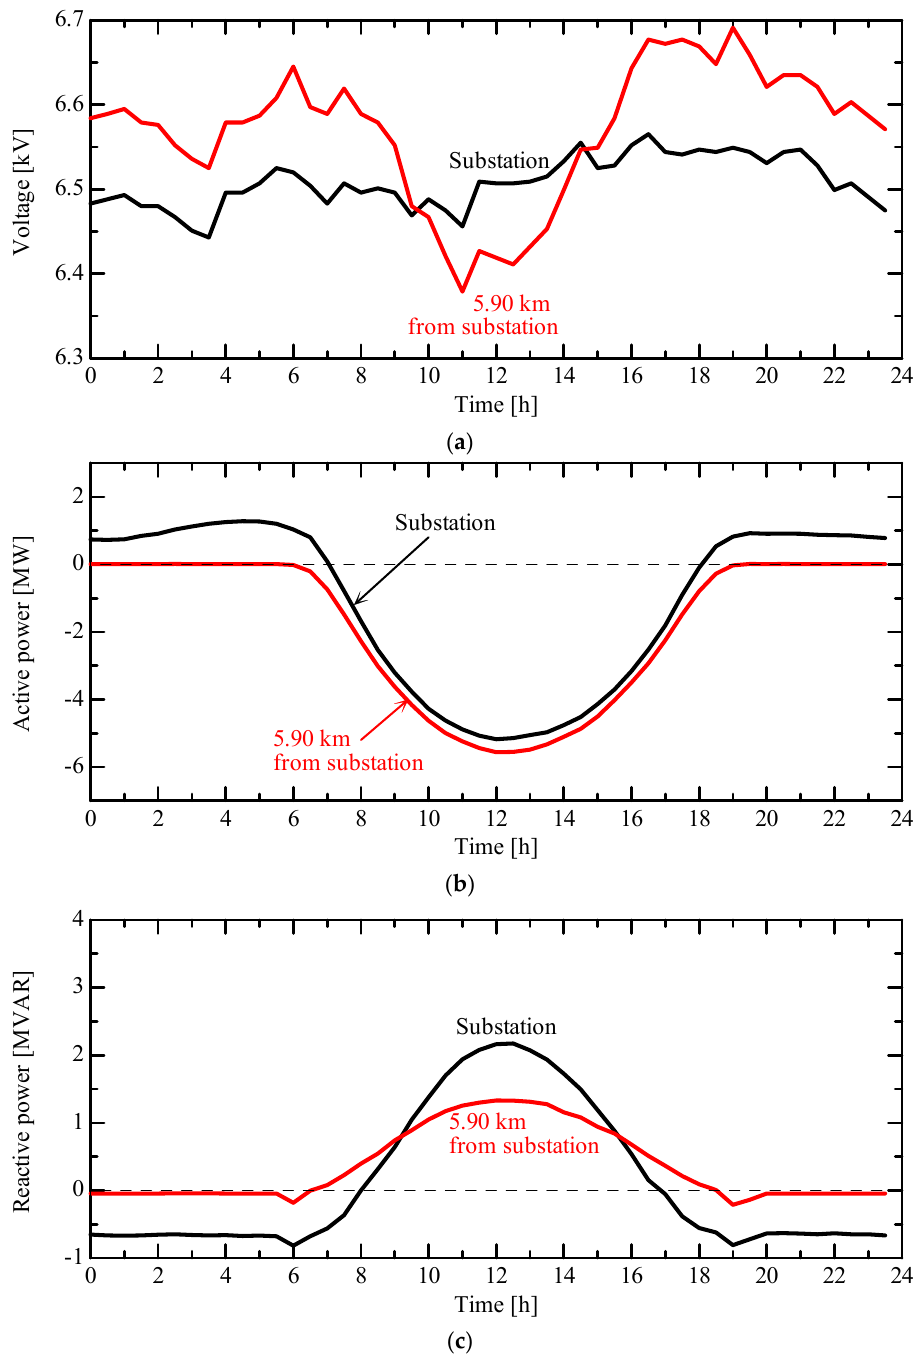
Figure 4. Measured voltage, active power, and reactive power in MV feeder C: ( a ) Voltage; ( b ) Active power; ( c ) Reactive power.